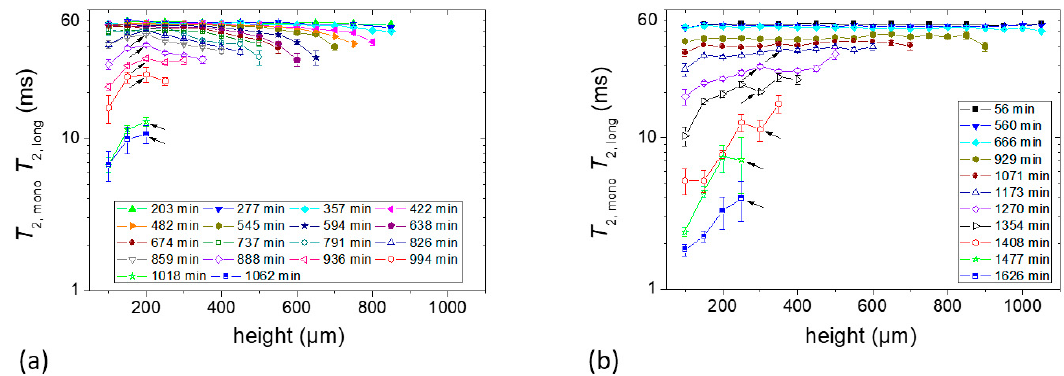
Figure 5. T 2 constants at different heights of the sample. ( a ) Sample c containing 1% starch in H 2 O ( w/v ) and ( b ) Sample d containing 5% starch in H 2 O ( w/v ). Each sample contained glycerol (20 g/100 g of starch) as a plasticizer. Layer positions correspond to coordinates introduced in Figure 3. At the later stage of drying, the echo decays were fitted with two exponential decay functions from the bottom of the sample to a certain height which is shown by the arrows. In the case of bi-exponential decay, the effective T 2 data shown in both figures correspond to the slowly decaying components.